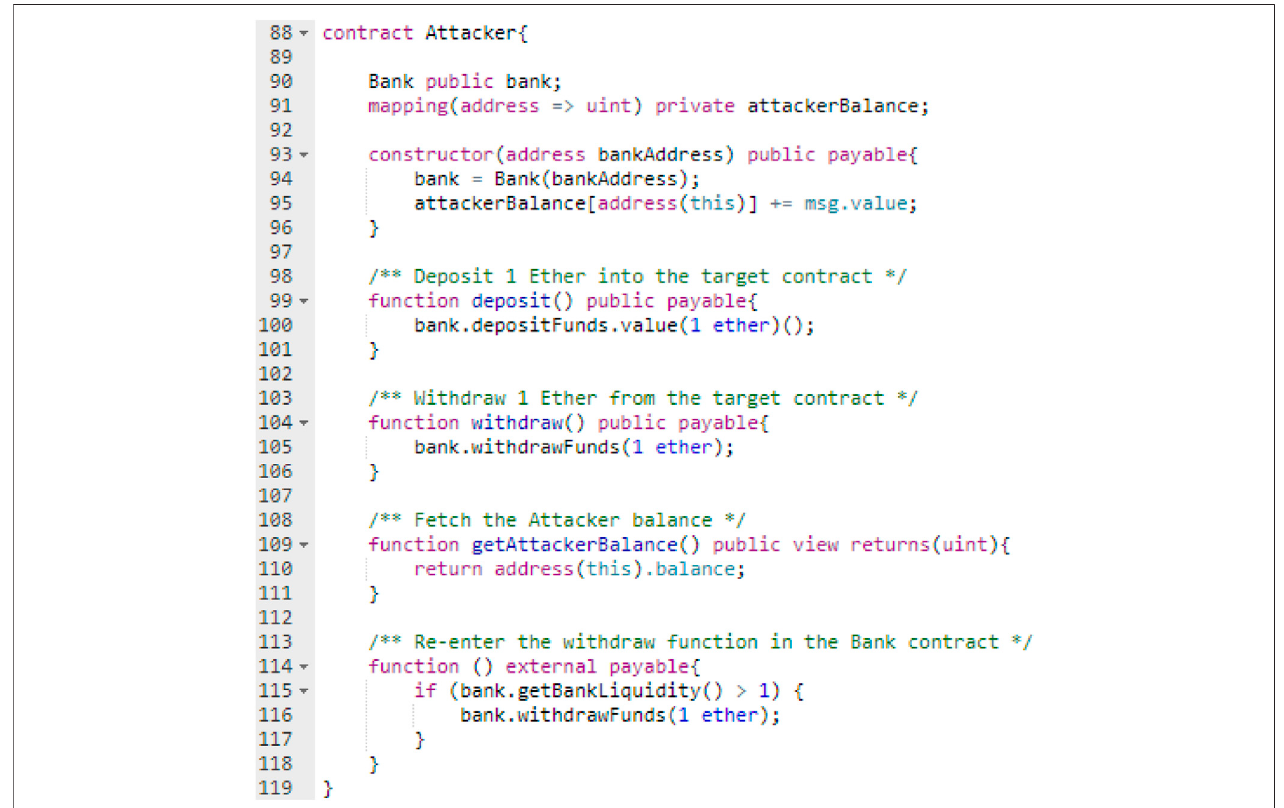
FIGURE 6 | The Attacker{}